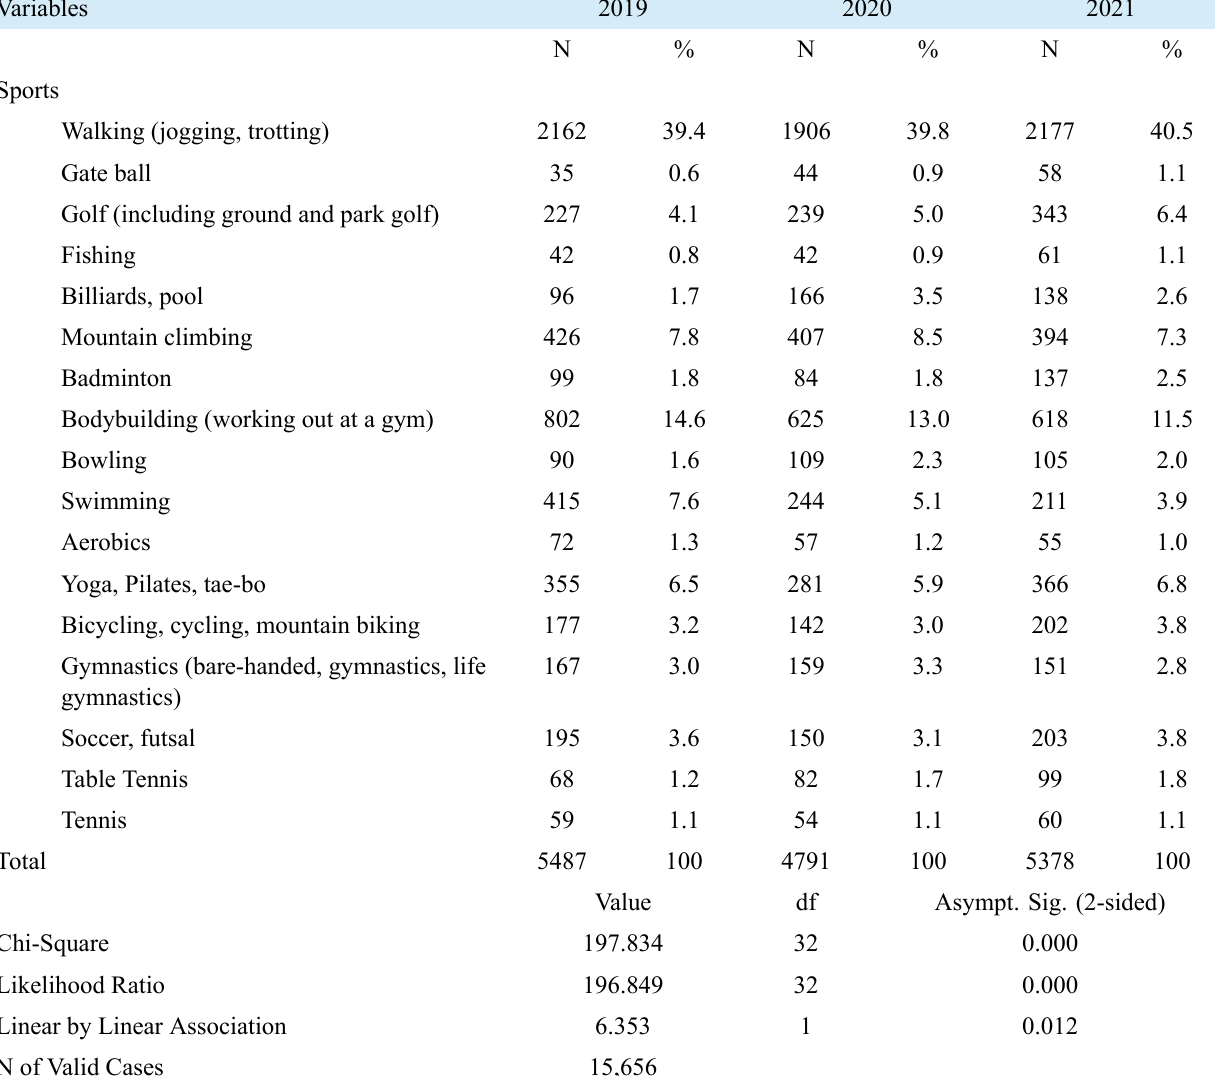
TABLE 2. Changes in sports activities by year (2019–2021).